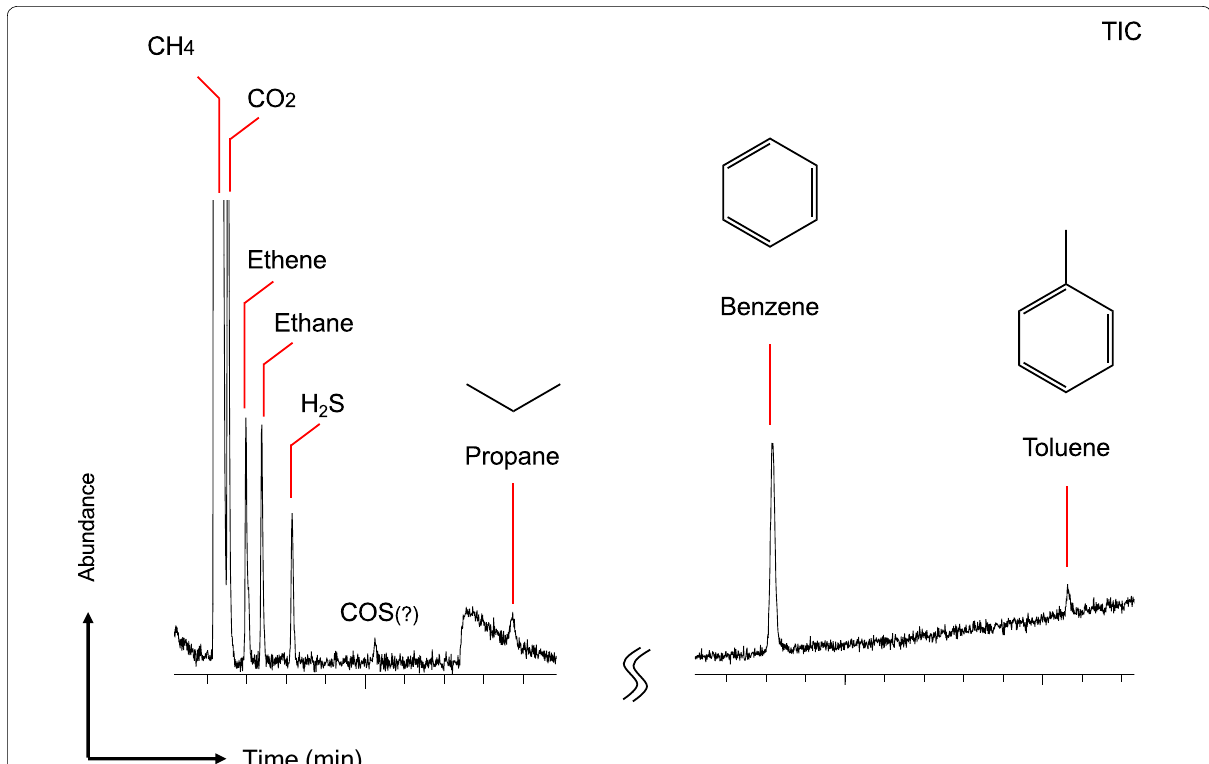
Fig. 5 GC/MS chromatograms showing the volatile gases (methane, carbon dioxide, ethene, ethane, hydrogen sulfide, propane, benzene, and toluene) from the quenched carbonaceous product (w/o sabot). TIC total ion